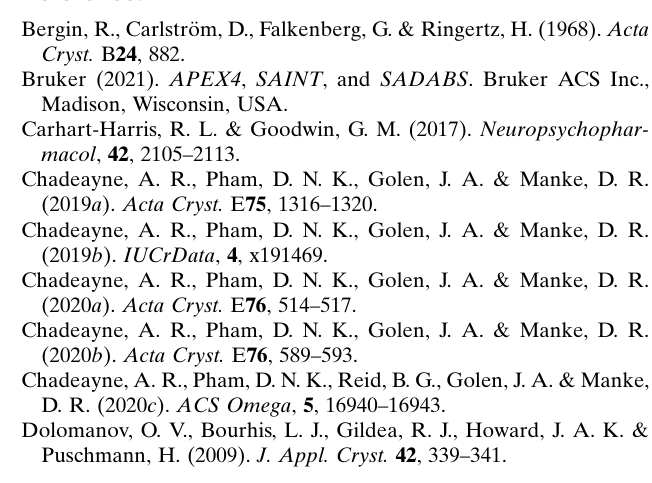
Crystal data Chemical